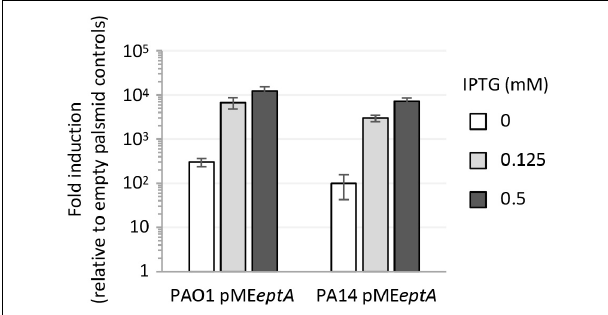
a Values correspond to the mode of at least six experiments. NT, not tested. b These recombinant strains constitutively express the arn operon and have Ara4N- modified lipid A (Lo Sciuto et al., 2020).